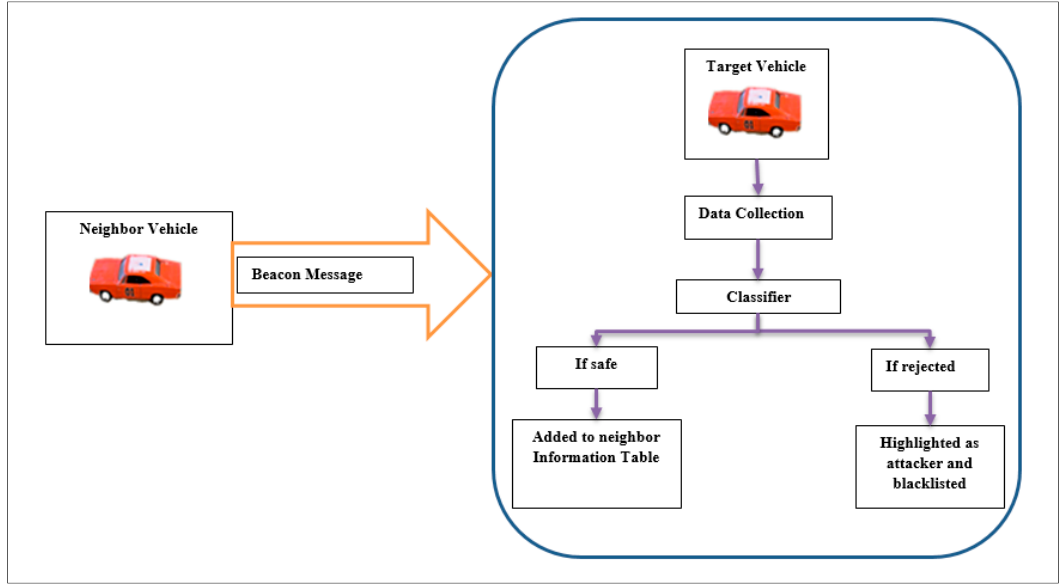
Figure 4. Detection attack in VANET.